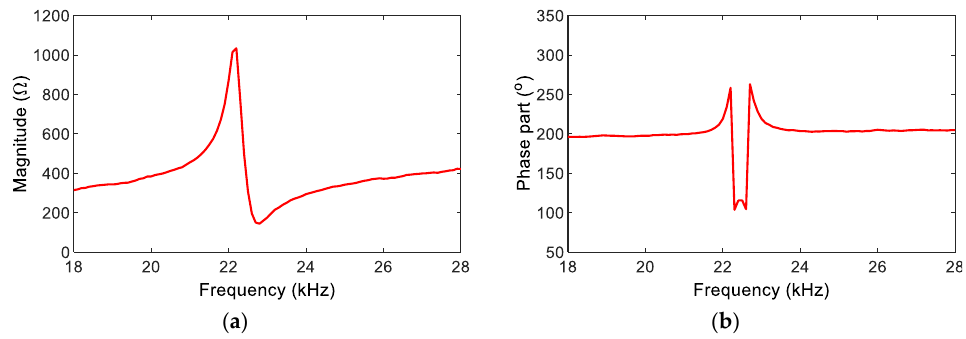
Figure 14. Calculation of impedance magnitude and phase angle for Raspberry Pi system. ( a ) Magnitude M P , ( b ) Phase angle ϕ P .